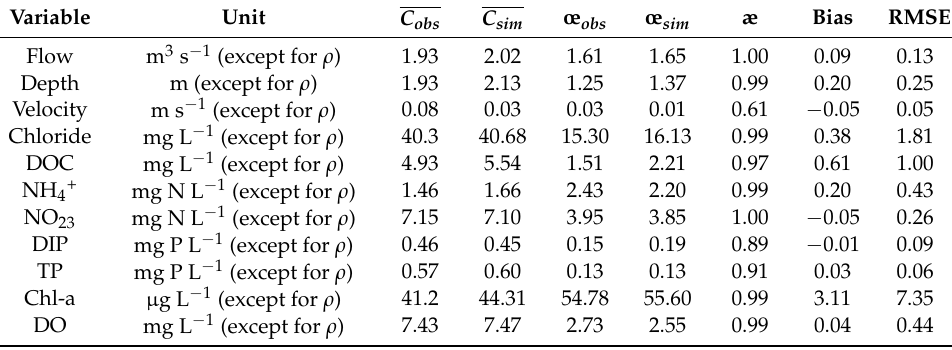
Table 1. Statistics calculated on observed and simulated variables: mean values ( C obs , C sim ) and standard deviations ( σ obs , σ sim ) of observed and simulated concentrations, correlation, bias, and RMSE.